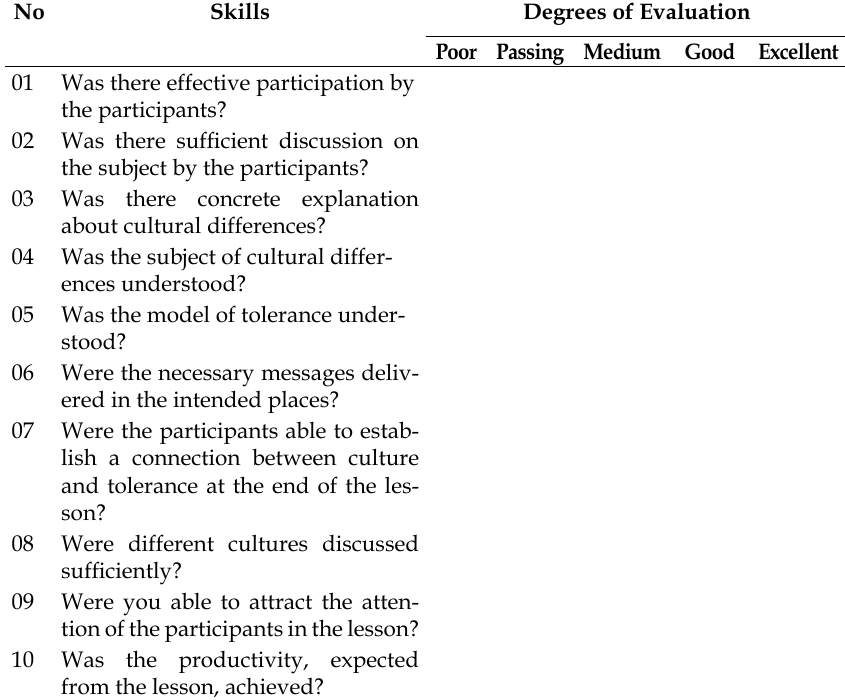
Table 7. Observation and evaluation